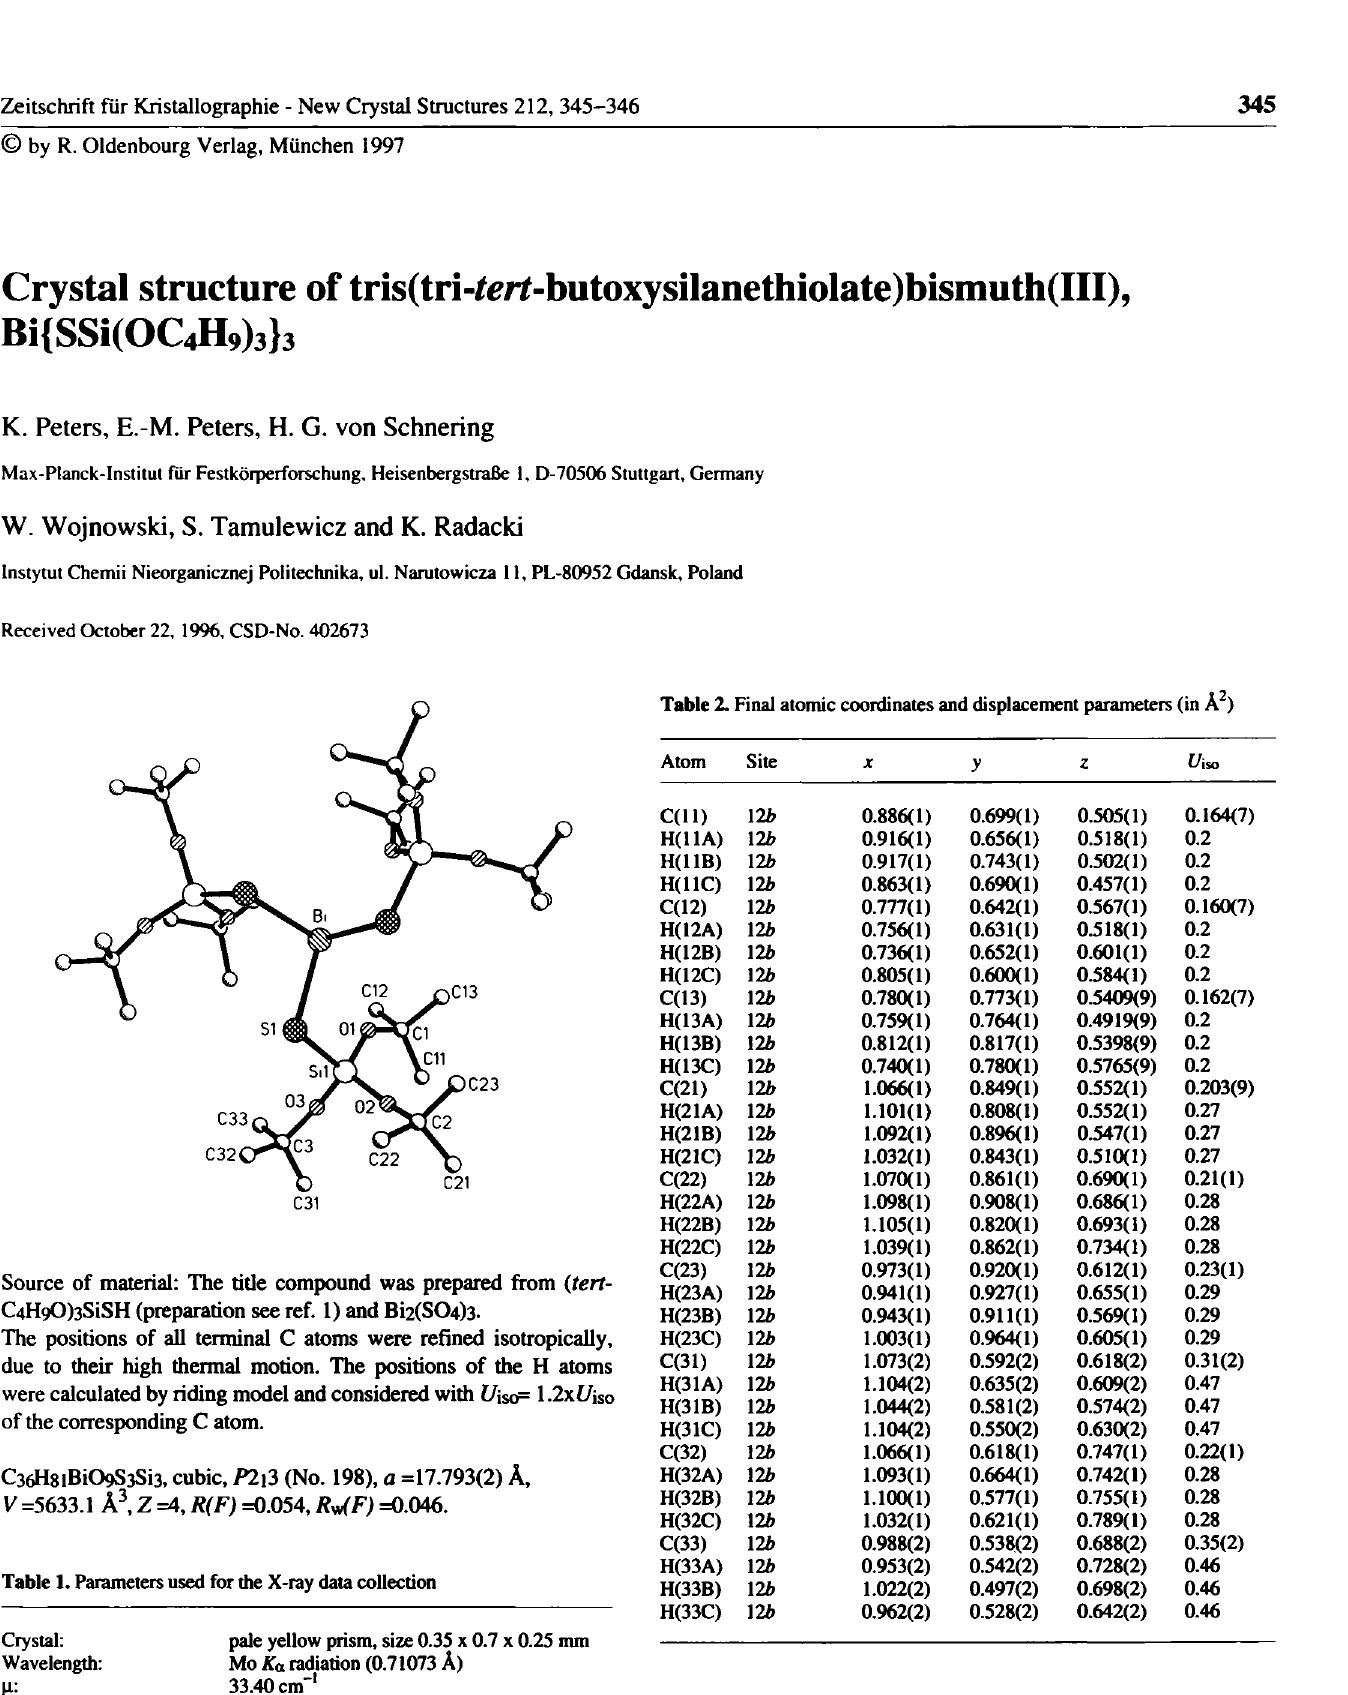
Table 1. Parameters used for the X-ray data collection